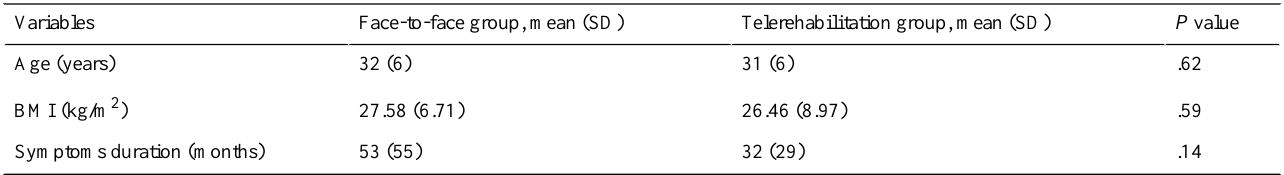
Table 2. Demographic characteristics of face-to-face and telerehabilitation